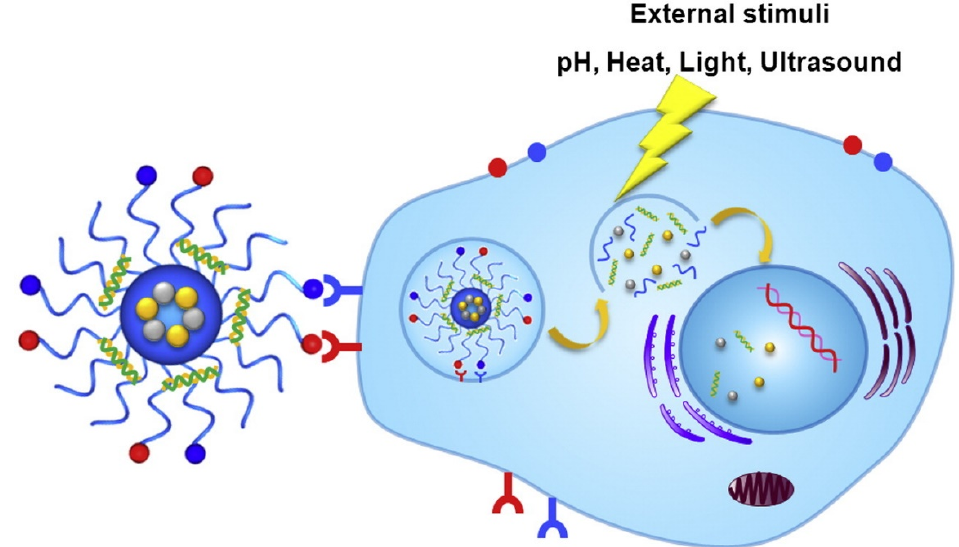
Figure 5. Schematic illustration of the stimuli-triggered drug release from the NPs. (Reprinted from [23], with permission from Elsevier). from [23], with permission from